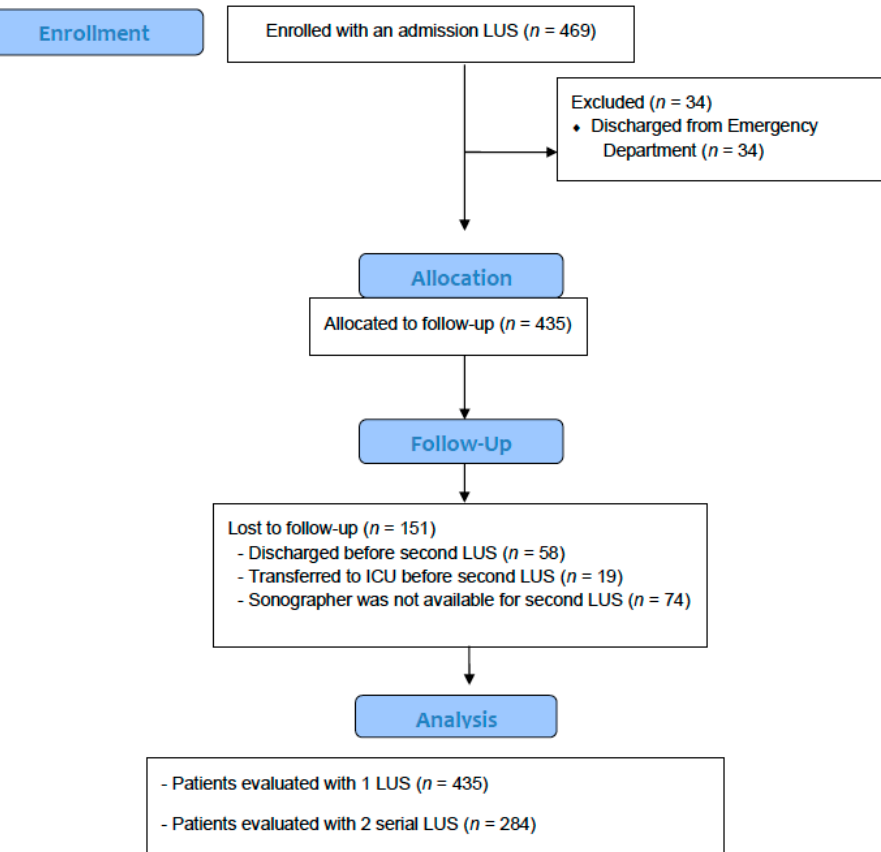
Figure 2. Consort 2010 flow chart of patients with COVID-19 admitted to Spanish hospitals and included in the PREDECHOVID study. LUS: lung ultrasound; ICU: intersive care